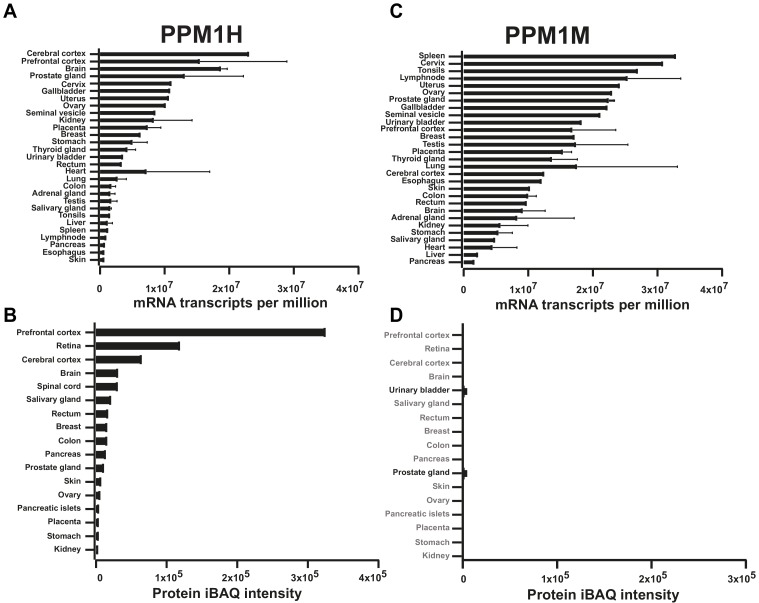
The abundance of PPM1H and PPM1M mRNA and protein in human tissues was analyzed using data downloaded from ProtemicsdB public repository database (https://www.proteomicsdb.org/) (Schmidt et al., 2018).The median mRNA expression across the tissues studied is depicted as transcripts per million. The median protein expression for both PPM1H and PPM1M is calculated as the average normalized iBAQ (intensity based absolute quantification).